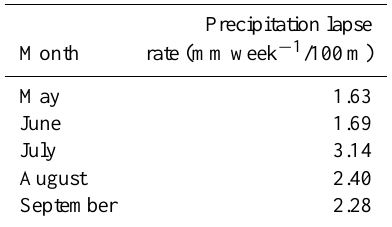
Figure 3. Proportion of monthly precipitation to annual amount (2003–2012). The red line in each box represents the median value for each month from 2003 to 2012. Red crosses indicate abnormal values that exceed 1.5 times the inter-quartile range. Table 2. Estimated weekly precipitation lapse rate in storm rain months.